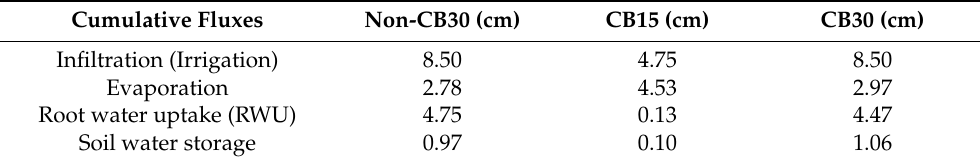
Figure 6. Scatter plots between simulated and observed volumetric soil water contents at depths of 3 ( top ) and 14 ( bottom ) cm for different experimental setups (Non-CB30—A homogeneous reference column and daily irrigation of 0.30 cm ( left ), CB15—A column with a CB and daily irrigation of 0.15 cm ( middle ), and CB30—A column with a CB and daily irrigation of 0.30 cm ( right )). Table 5. Simulated values of cumulative infiltration, evaporation, root water uptake (RWU), and soil water storage for different experimental scenarios (Non-CB30—A homogeneous reference column and daily irrigation of 0.30 cm, CB15—A column with a CB and daily irrigation of 0.15 cm, and CB30—A column with a CB and daily irrigation of 0.30